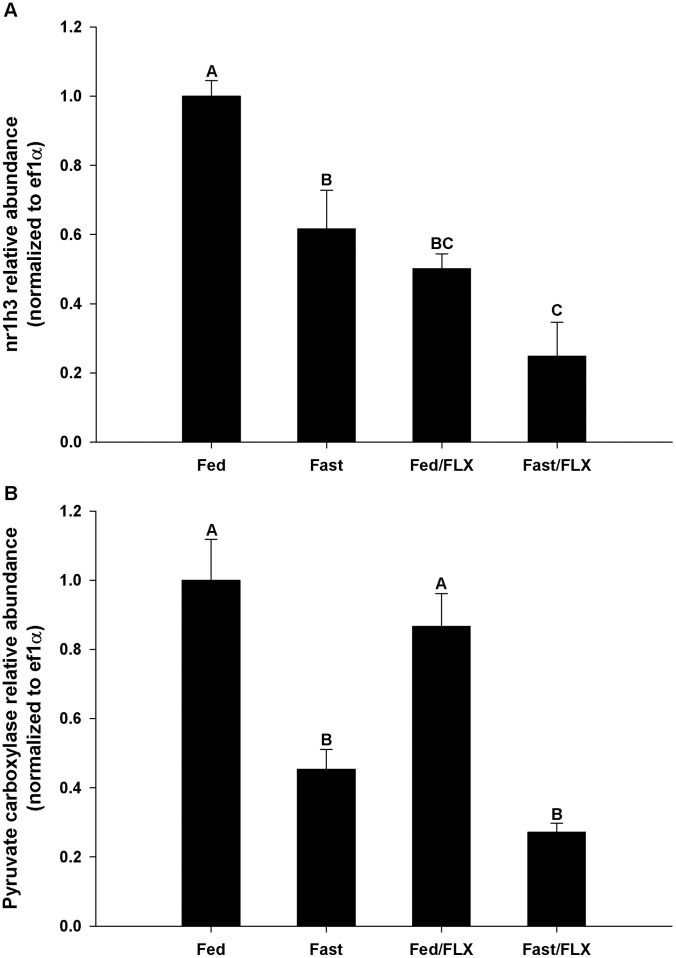
Relative transcript abundance of (A) nr1h3 (liver X receptor) and (B) pyruvate carboxylase to ef1α across all treatments.Values are presented as the average ± S.E.M. (n = 4). Bars that do not share a common letter are significantly different from each other, as determined by a one-way ANOVA and Tukey’s post-hoc test (p<0.05).